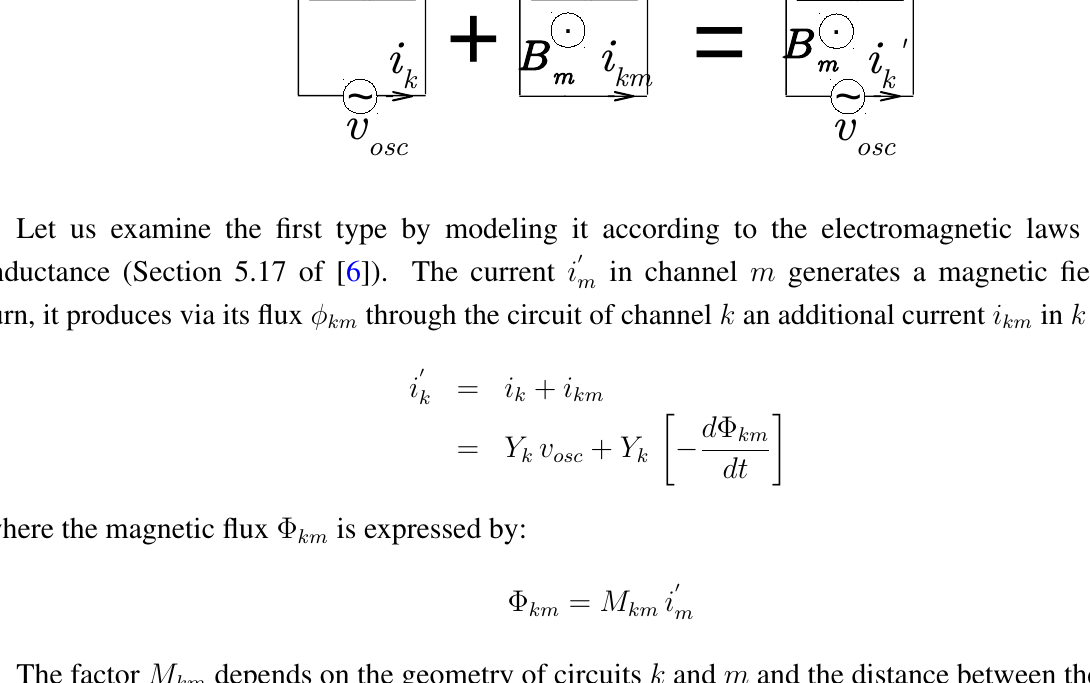
Figure 4. The total current i (cid:48) directly to the admittance Y through its magnetic field B